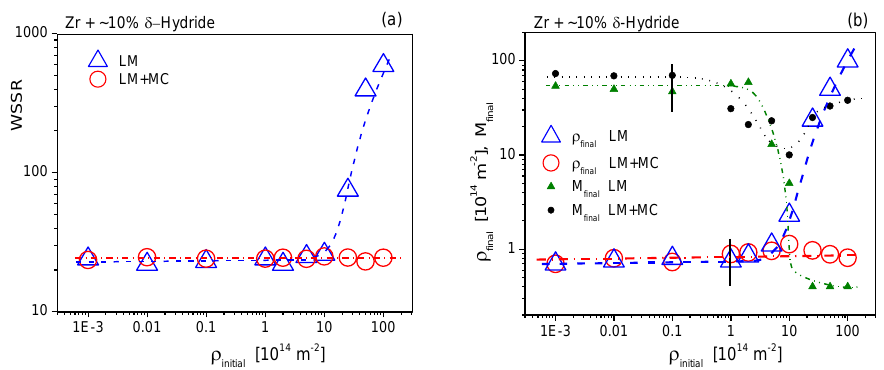
Figure 5. Systematic investigation of the LM and MC optimization procedures. ( a ) The WSSR vs. the initial value of the dislocation density, ρ initial , when LM alone (open blue triangles) and the LM and MC (open red circles) optimization procedures were used. ( b ) The final dislocation density and dipole character parameter values, ρ final and M final , vs. the initial, values, ρ initial and M initial , in logarithmic scales, calculated using either the LM alone (open blue triangles and green triangles) or the LM and MC optimization procedures (open red circles and black dots). The vertical black lines indicate error bars. All curves in the two figures are only to guide the eye.